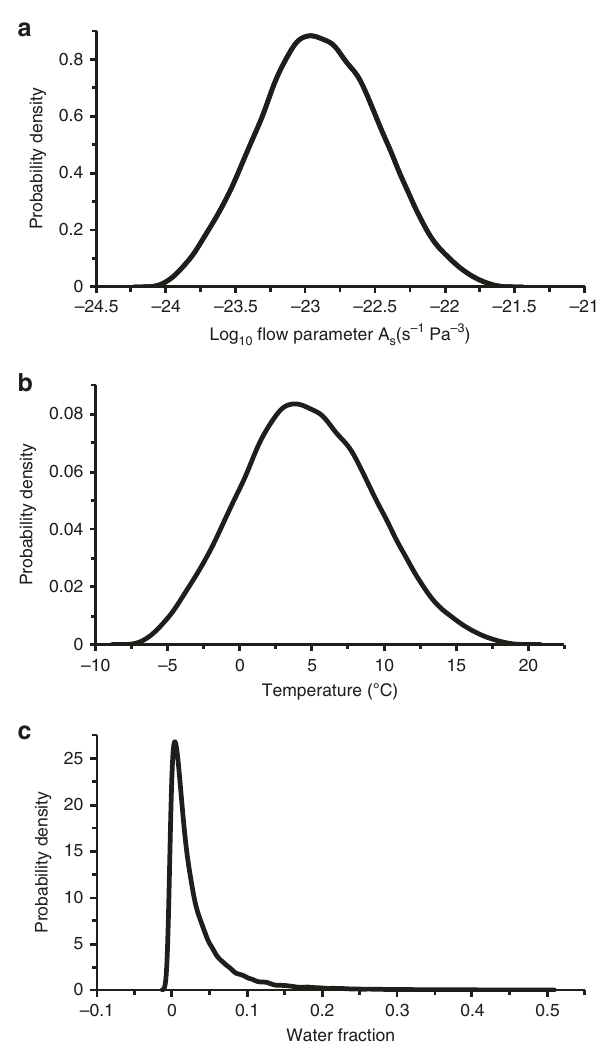
Fig. 9 Viscous buckling analysis of GPR data. Estimated probability densities of bulk suture-zone properties are shown, including a combined rate factor ( A s in Eq. (4)) for the softer layers VBM-1 (equivalent to ISU-1) and VBM-3 (integrating ISU-3 to ISU-5) (Fig. 4c, d), b ice temperature ( T in Eq. (5)) for these layers and c ice seawater fraction for these layers ( W in Eq.